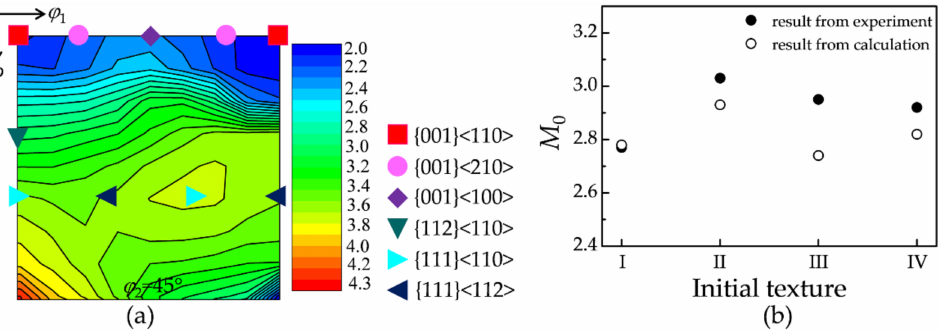
Figure 8. ( a ) A constant ϕ 2 = 45 ◦ section of the Taylor factor distribution; ( b ) the calculated and measured M 0 values for the four initial